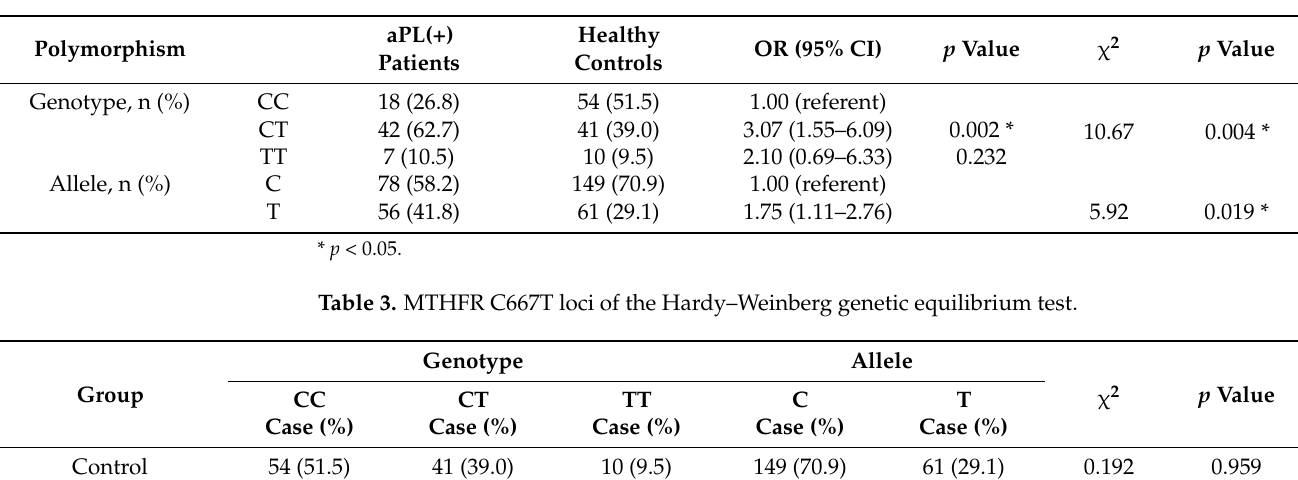
Table 2. MTHFR C677T genotype and allele distribution in aPL(+) patients and healthy controls.